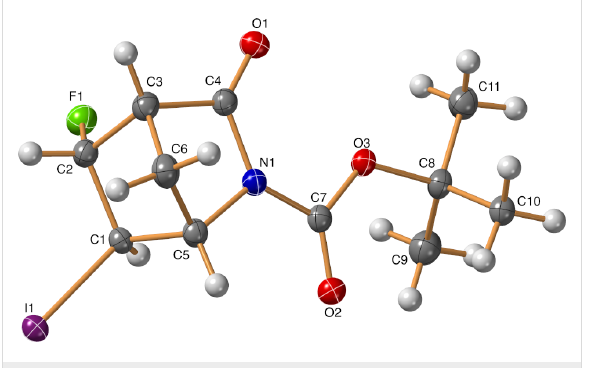
Figure 3: Crystal structure of the product ( rac ) - 15b